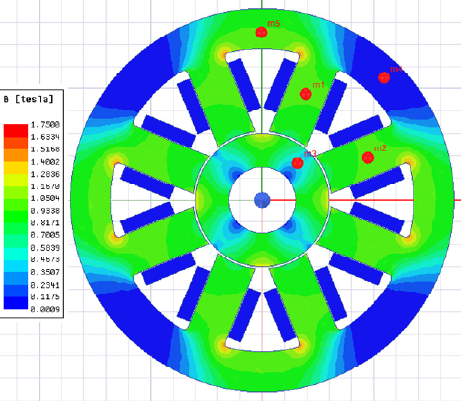
Figure 15. C ‐ type magnetic circuit magnetic field simulation of 8 ‐ pole RMBs. Figure 15. C-type magnetic circuit magnetic field simulation of 8-pole RMBs.